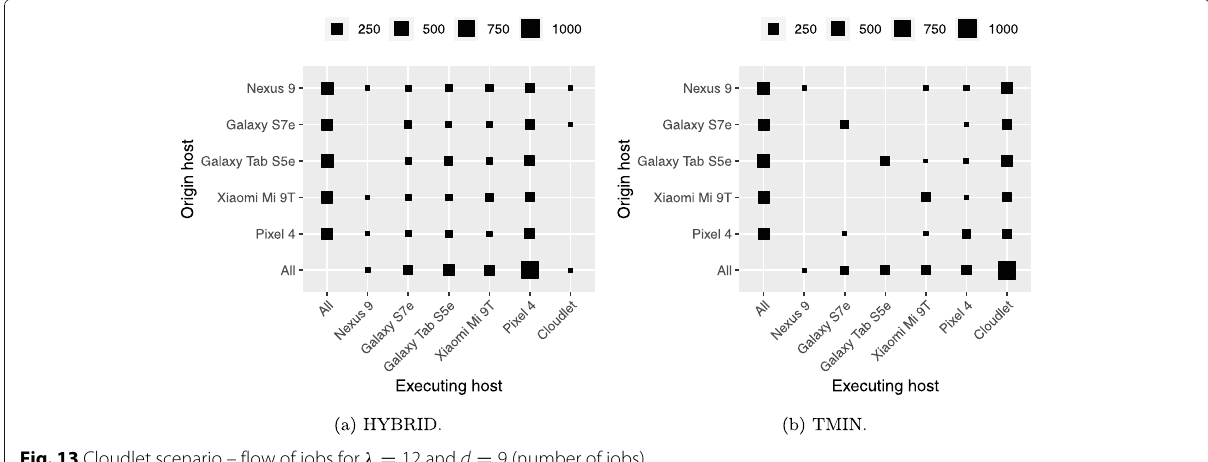
Fig. 13 Cloudlet scenario – flow of jobs for λ = 12 and d = 9 (number of